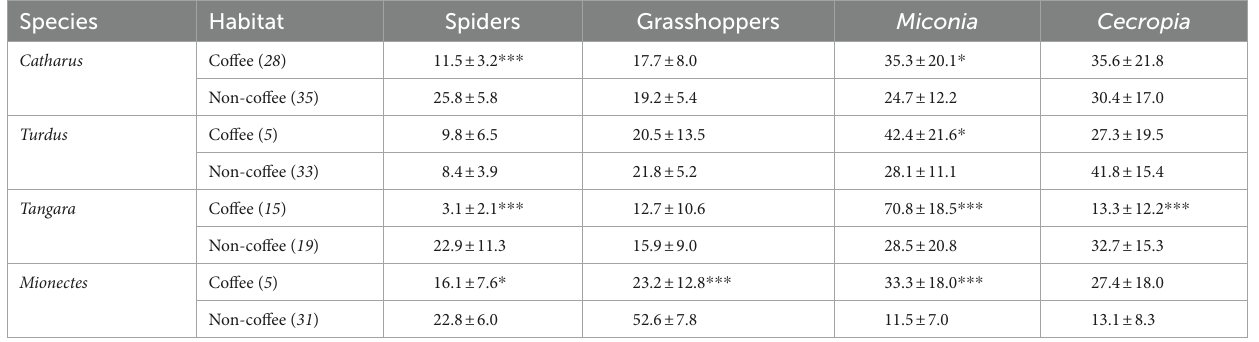
TABLE 2 Mean (±SD) contributions of potential prey to the diets of four bird species collected in coffee and non-coffee habitats.